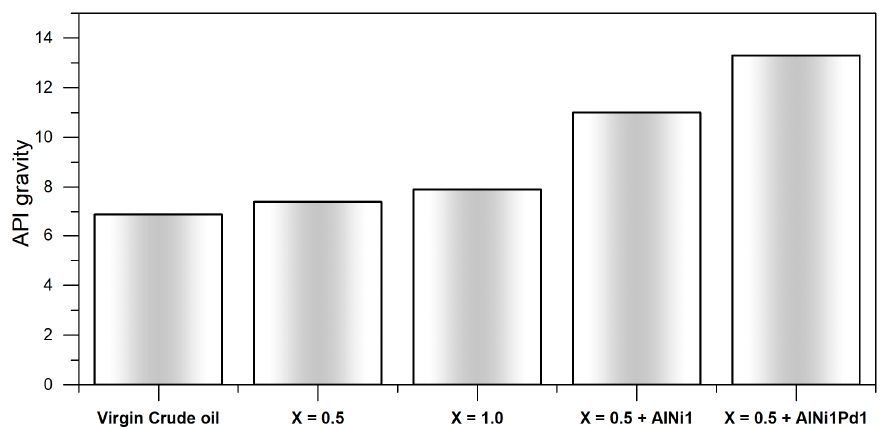
Figure 10. API gravity for untreated extra heavy oil and crude oil recovered after the steam injec- tion at X = 0.5, X = 1.0, and X = 0.5 + AlNi1 and